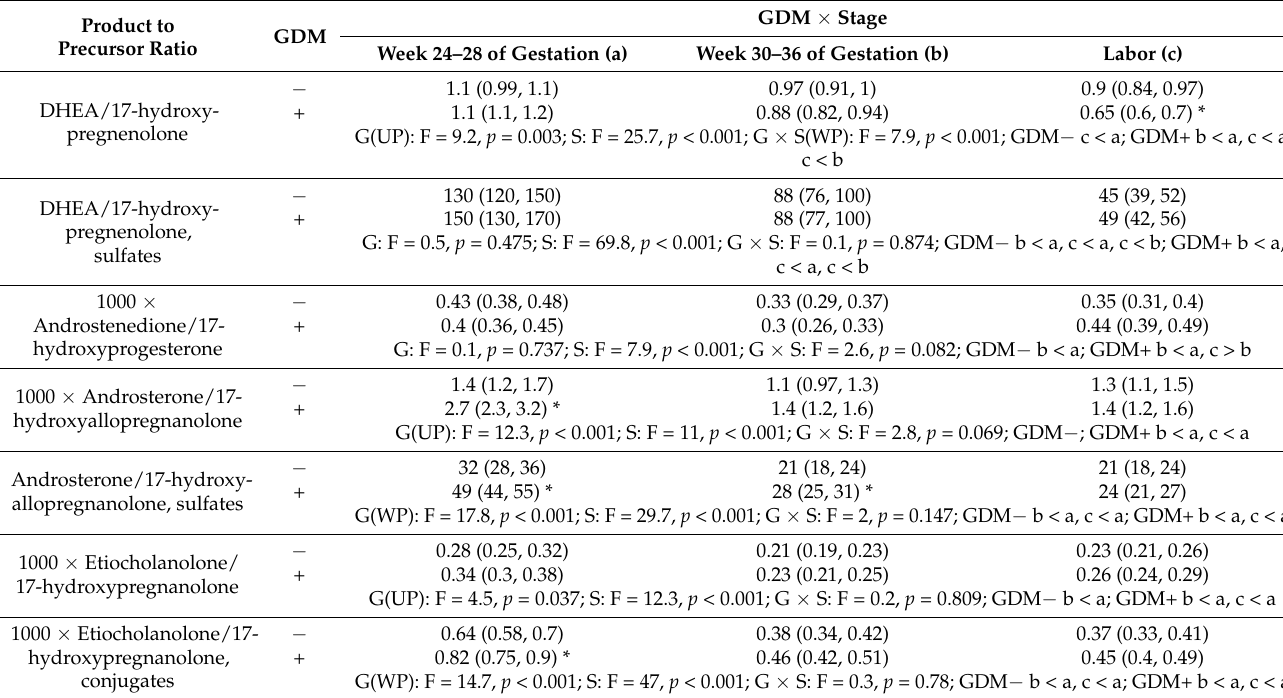
Table 3. Profiles of product to precursor ratios that may reflect balance between 17-hydroxy-steroids and corresponding C19-steroids and possibly also the activity of CYP17A1 (C17,20-lyase step) in the GDM − and GDM+ groups from week 24 of gestation to